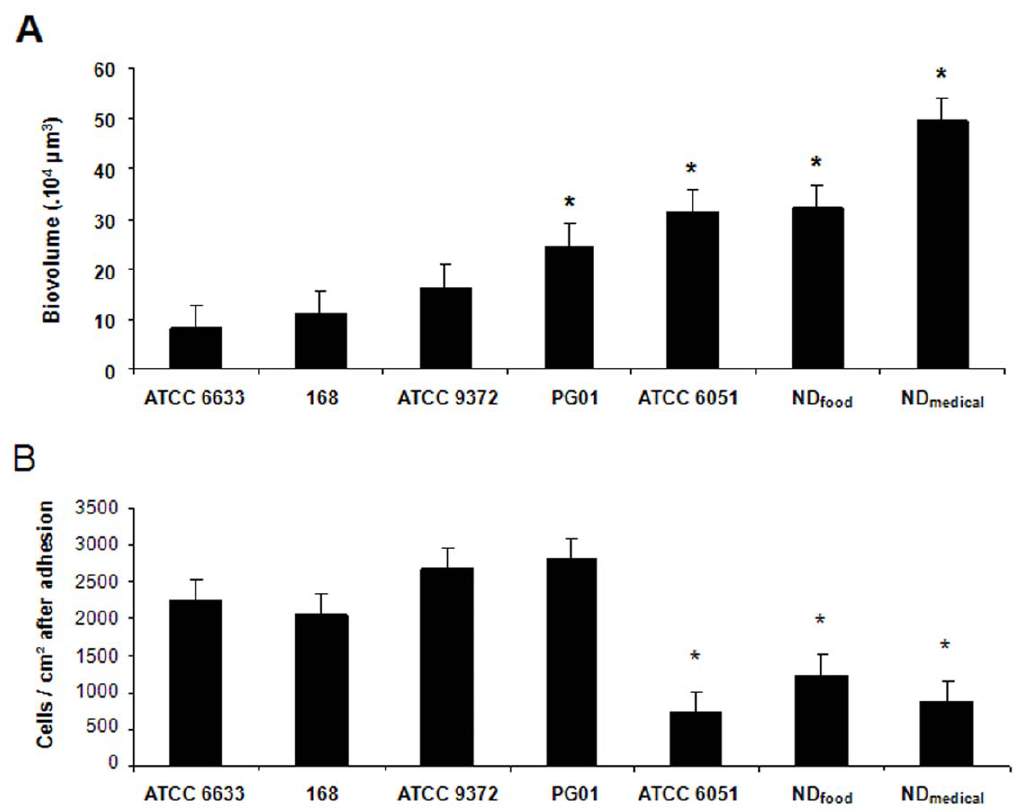
Figure 2. Biofilm biovolumes and the initial adhesion levels of the seven B.subtilis strains. (A) The biovolumes ( m m 3 ) in ascending order of the 48h-biofilms obtained with the seven B. subtilis strains in microtiter plates from confocal image series using the PHLIP tool. (B) Number of cells adhering per cm 2 after 1h30 of adhesion in the microtiter plate. The error bars indicate the standard error and the statistically significant difference observed with strain 168 ( P , 0.05) is indicated by a star (*).